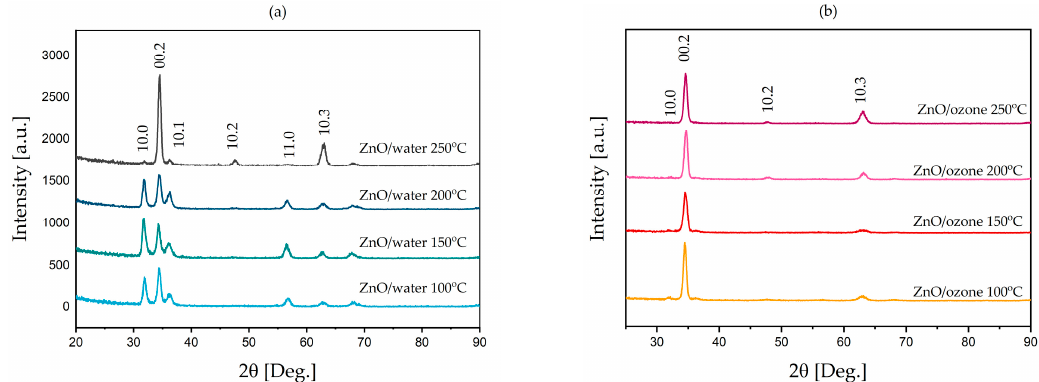
Figure 4. Non-coplanar grazing incidence X-ray diffraction (GIXRD) data of the measured layers: ( a ) ZnO water-based samples ( b ) and ZnO ozone-based samples. ( a ) ZnO water-based samples ( b ) and ZnO ozone-based